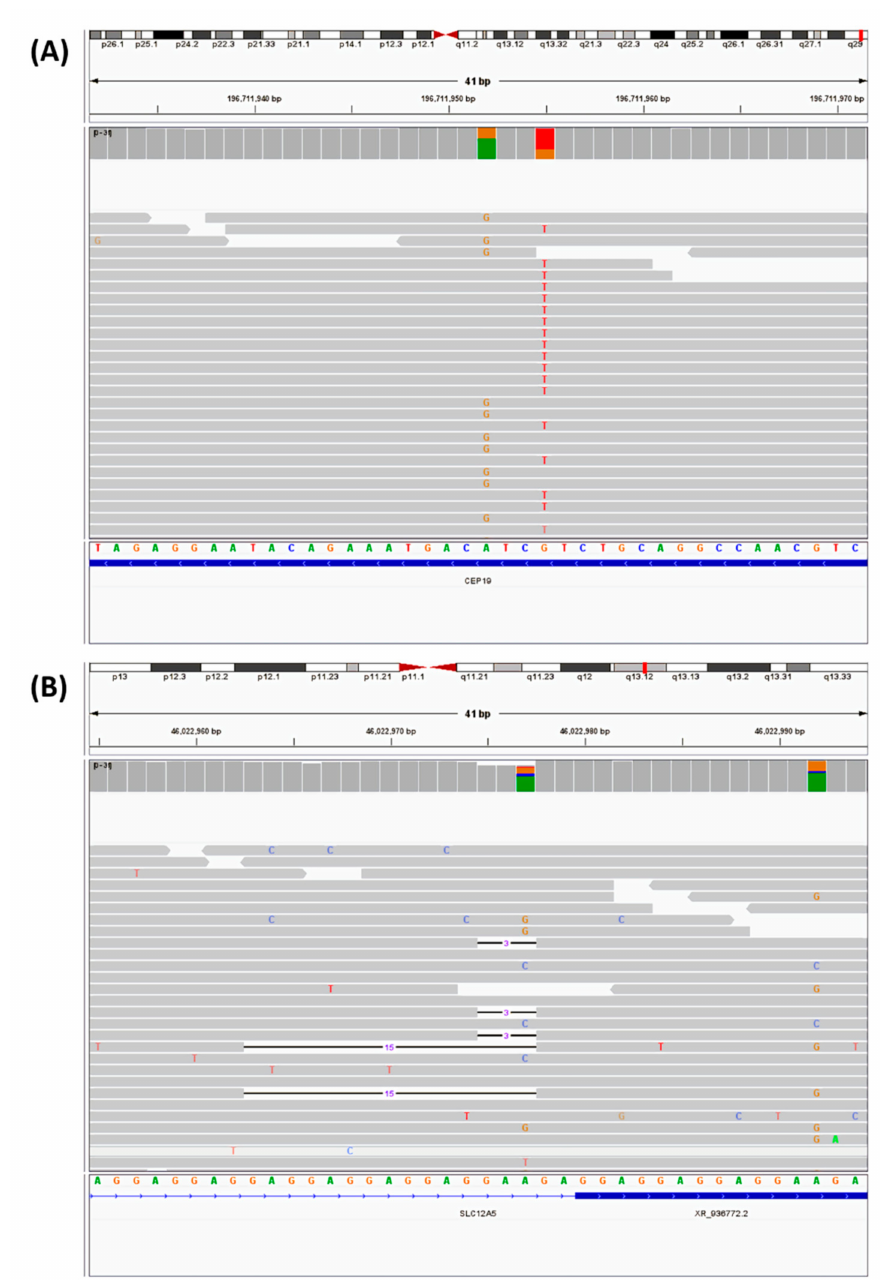
Figure 2. IGV view of two example variants identified by the bioinformatics pipeline. ( A ) A single nucleotide variation on the CEP19 gene of chromosome 3. ( B ) A potentially complex variation on the SLC12A5 gene of chromosome 20. This region was shown to have two in-frame deletion variants, but subsequent manual review found another de novo A:G single nucleotide substitution variant at base pair 46022977, which is confirmed by Sanger sequencing. The two in-frame deletions are not confirmed and most likely represent sequencing